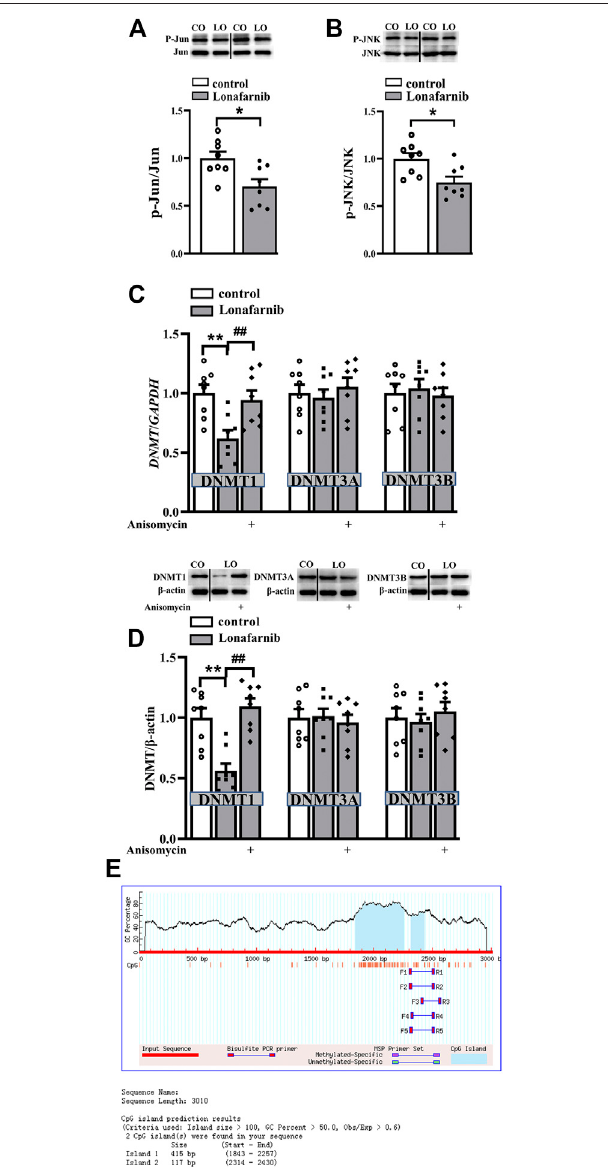
FIGURE3| Lonafarnibadministrationdownregulatesthephosphorylationof C-JunandJNKpathwayand,inthisway,decreasesDNMT1inthehippocampus. (A and B) Levels of phospho-Jun and phospho-JNK in control and lonafarnib- treatedmice,*P < 0.05vs.controlmice( t -test). (C) Levelsof DNMT1/3A/3B mRNA in the hippocampus of control mice and lonafarnib-treated mice treated with vehicle or anisomycin. ** P < 0.01 vs. control mice; ## P < 0.01 vs. lonafarnib- treatedmice(two-wayANOVA,followedbyTukey ’ smultiplecomparisontest). (D) Levels of DNMT1/3A/3B proteins in the hippocampus of control mice and lonafarnib-treated mice treated with vehicle or anisomycin, ** P < 0.01 vs. control mice; ## P < 0.01 vs. lonafarnib-treated mice (two-way ANOVA, followed by Tukey ’ s multiple comparison test). (E) Prediction of CpG island in the promoter regionof CHRNA7 gene.TheexpressionofmRNAandproteinwerenormalizedby the values of control group with